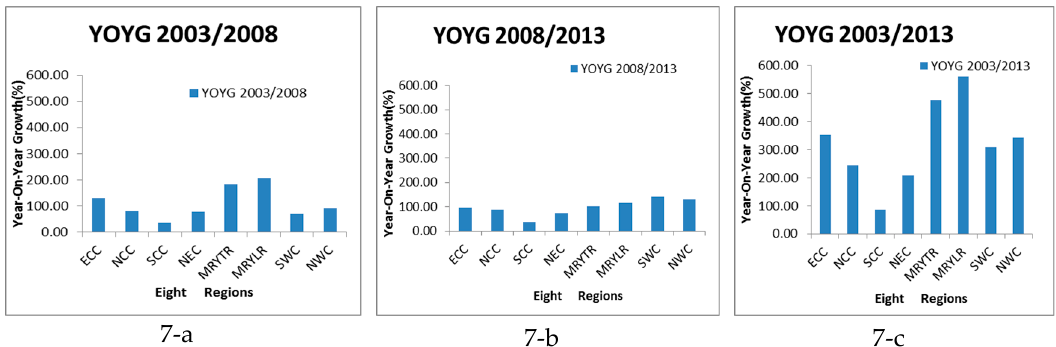
Relative to a specific period, the differentiation in urbanization expansion speed in 399